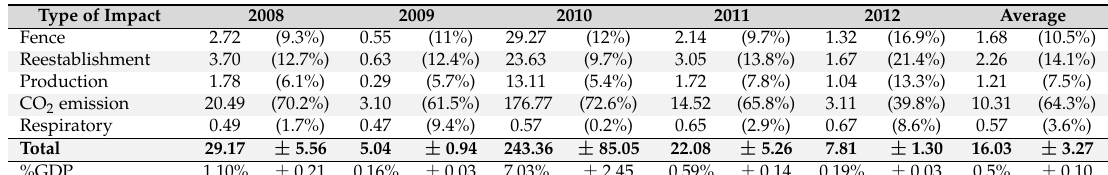
Table A10. Cost in millions of dollars of losses by fire in Acre state between 2008 and 2012, with a percent of total costs (%) and a related percent of total GDP.